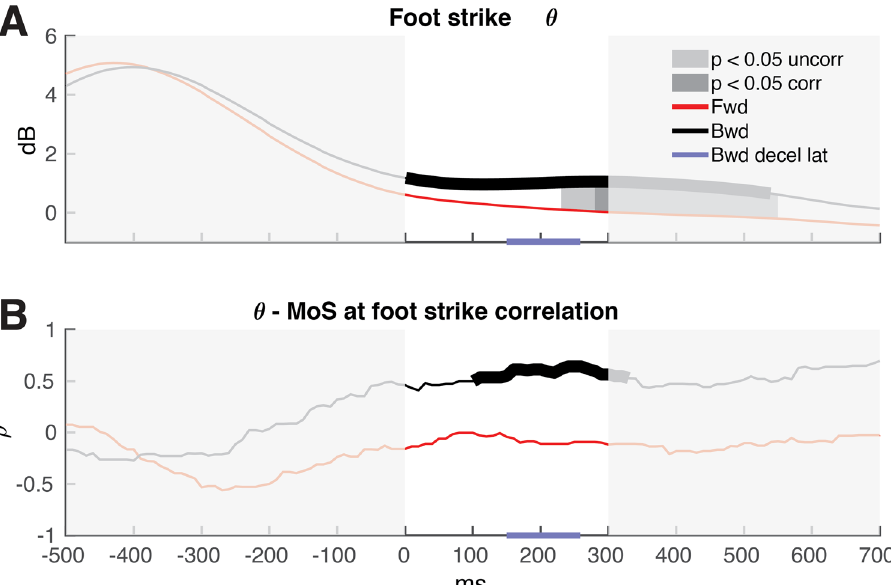
Figure 4. Foot strike time-locked theta time series. ( A ) Average theta time series for both stepping directions, with forward (Fwd) stepping indicated in red and backward (Bwd) stepping indicated in black. The highlighted white background indicates the temporal window where platform deceleration effects on theta dynamics are minimal. Significant difference in theta power between backward foot strikes relative to baseline with corrected false detection rate (fdr) is presented with a thicker line. Significant differences in theta power dynamics between stepping directions are indicated with dark grey (fdr corrected, ‘corr’) and light grey (uncorrected, ‘uncorr’). The horizontal blue line on the x-axis represents the average latency of platform deceleration onset (Bwd decel lat) relative to the instant of foot strike and standard deviation during backward stepping trials.